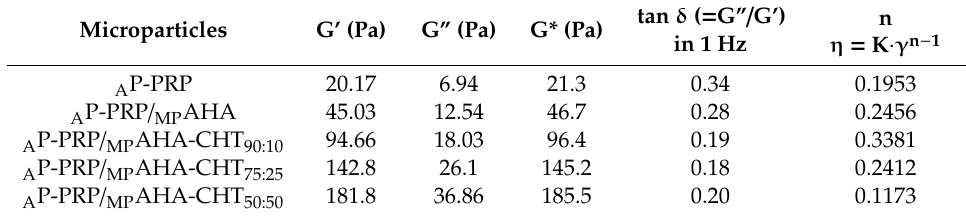
Table 2. Mechanical properties of the associations A P-PRP / MP AHA and A P-PRP / MP AHA-CHT.